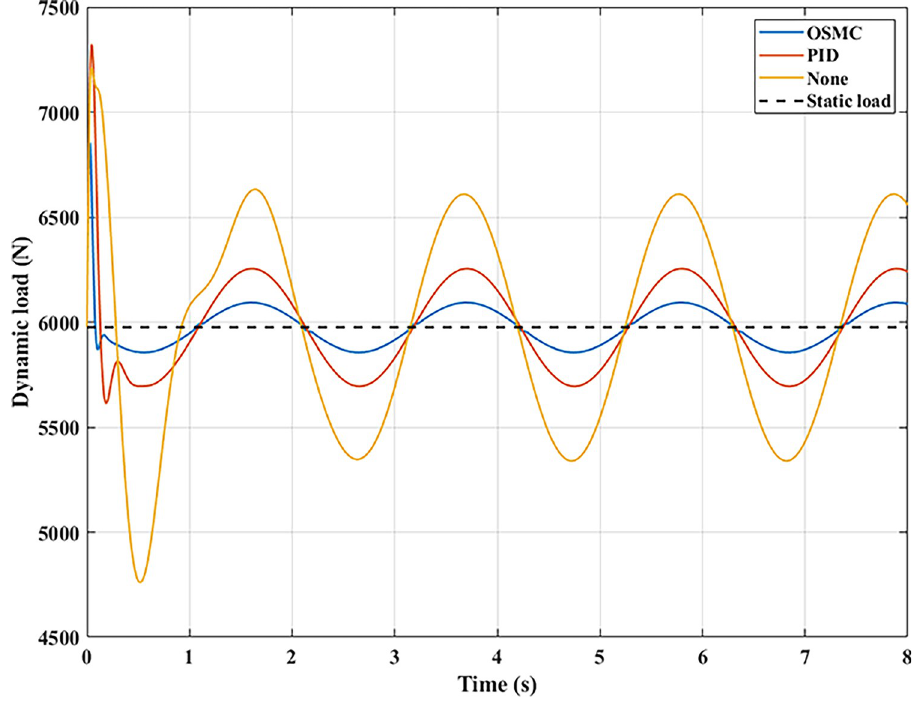
Fig 14. Dynamic load (case